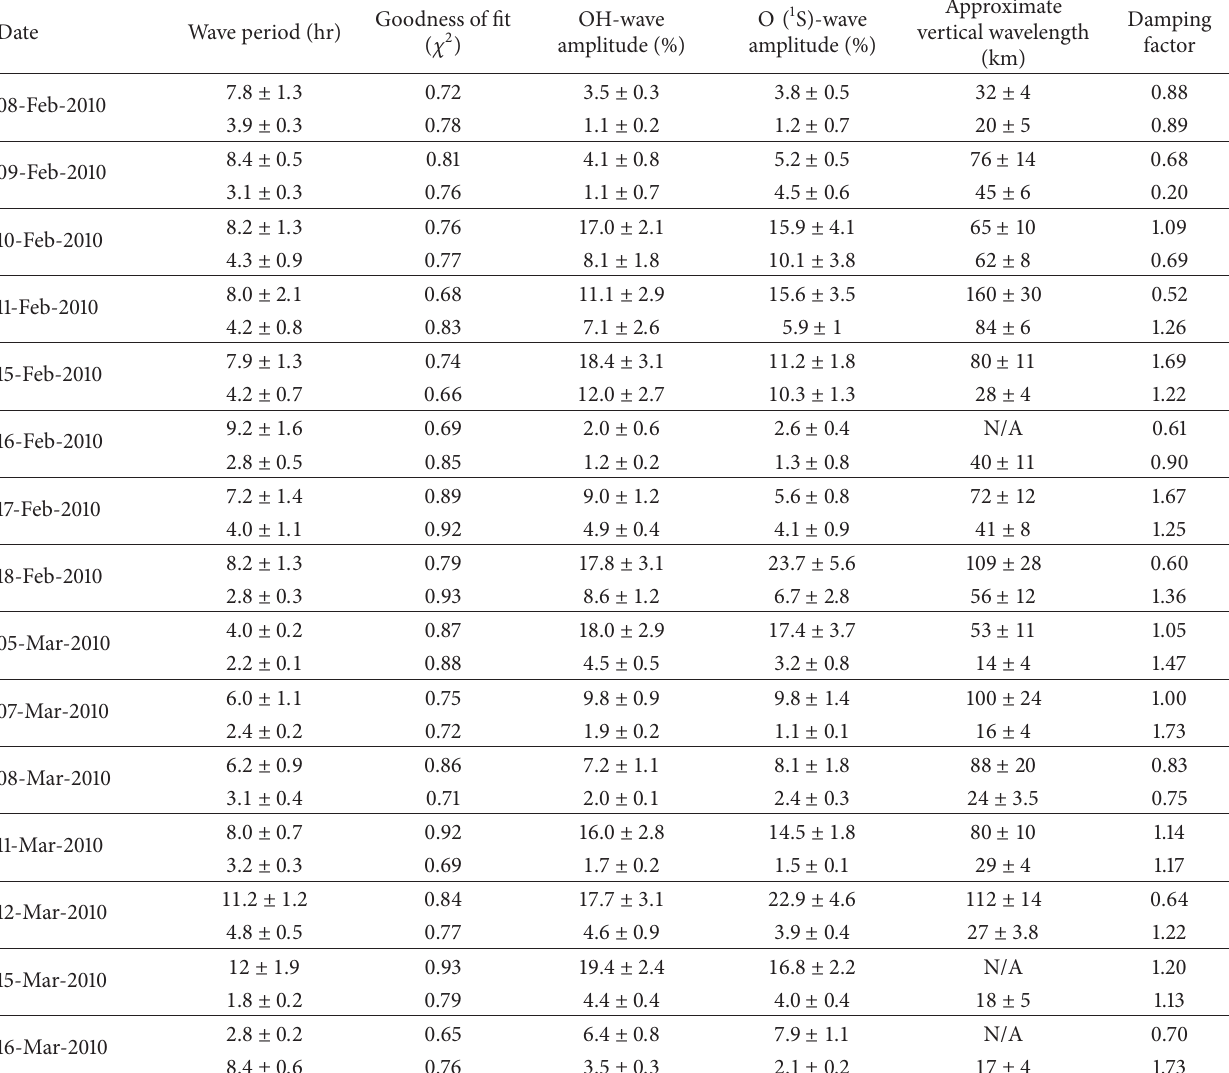
Table 1: Observed wave characteristics over Kolhapur during the February-March 2010 campaign are shown for each night (first and second rows on each night show principal and residual waves). The best-fitted wave periodicity and wave amplitudes are shown together with the goodness of fit measured as 𝜒 2